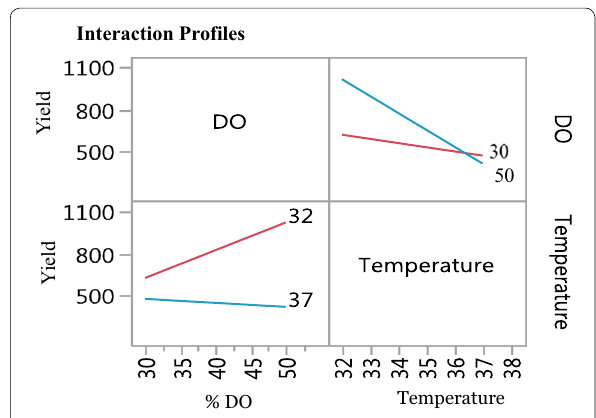
Fig. 3 Interaction profiler within design-fit model created by JMP software. Interactions between terms show up as crossed lines or lines of different slopes. No interaction is shown as parallel lines. In this figure, DO and temperature interact as indicated by lines of different slopes and lines that will cross each other